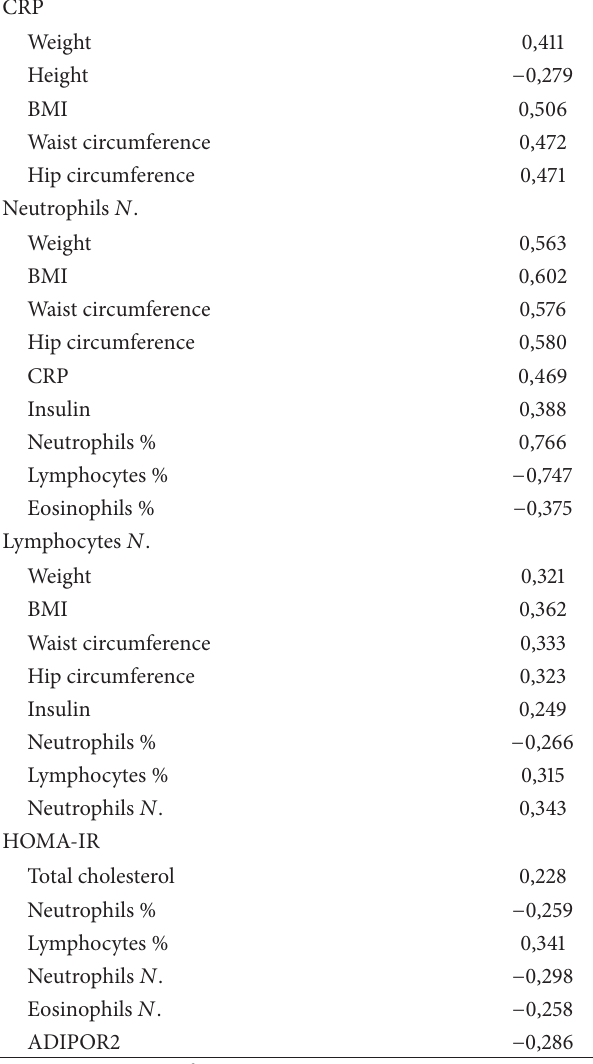
Table 4: Correlations of inflammatory markers and insulin resis- tance with all other parameters investigated in the study. Only significant correlations with the respective 𝑟 coefficient are reported ( 𝑃 < 0.05